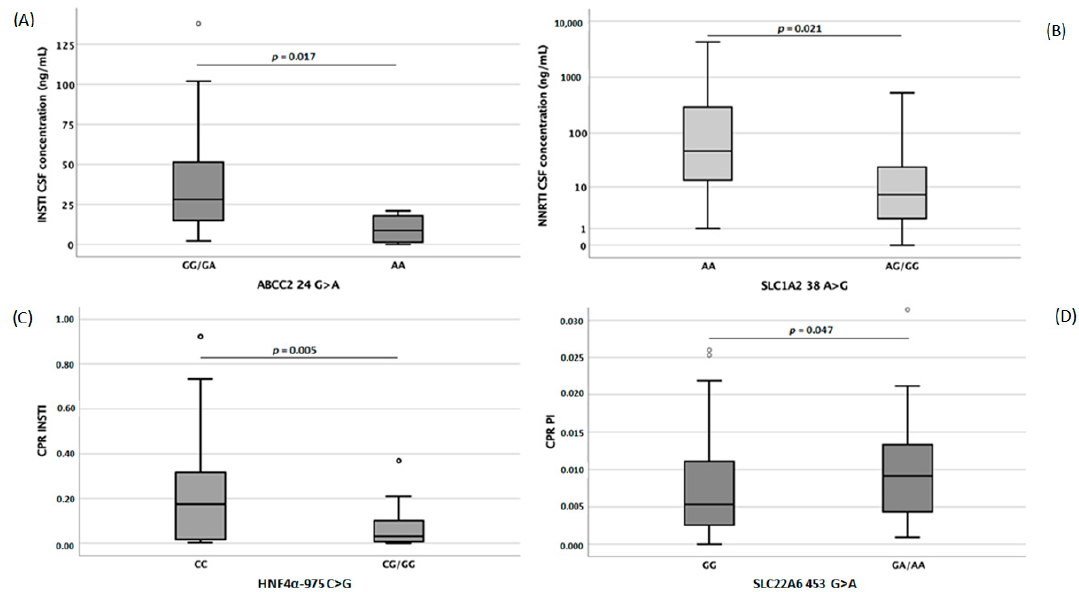
Figure 4. Cerebrospinal fluid (CSF, ( A ) for integrase inhibitors, INSTI and ( B ) for non-nucleoside reverse transcriptase inhibitors, NNRTI) and cerebrospinal fluid/plasma ratio (( C ) for INSTI and ( D ) for protease inhibitors, PI) concentrations of different antiretroviral drugs according to single-nucleotide polymorphism.